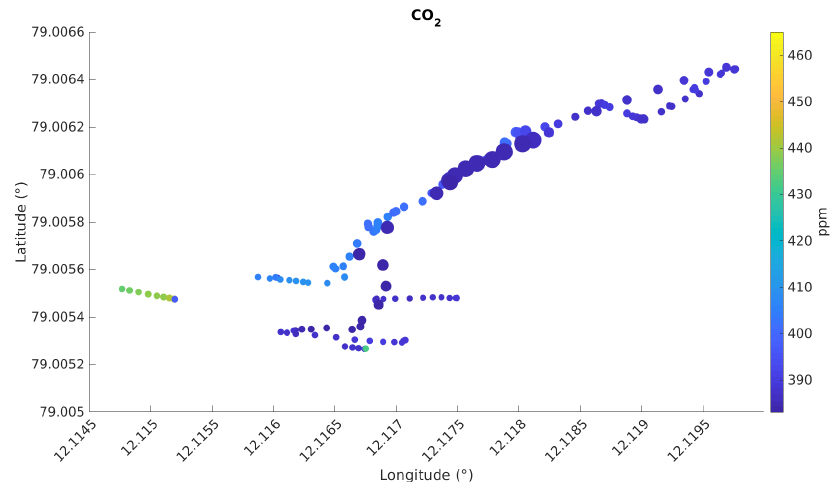
concentrations (in ppm, colour-bar on the right) and the sizes of the circles are scaled on the UAV altitude (bigger circles indicating higher altitudes). As shown, bigger circles tend to correspond to lower CO 2 values. The height goes from 2 m (smaller circles) to 62 m (bigger